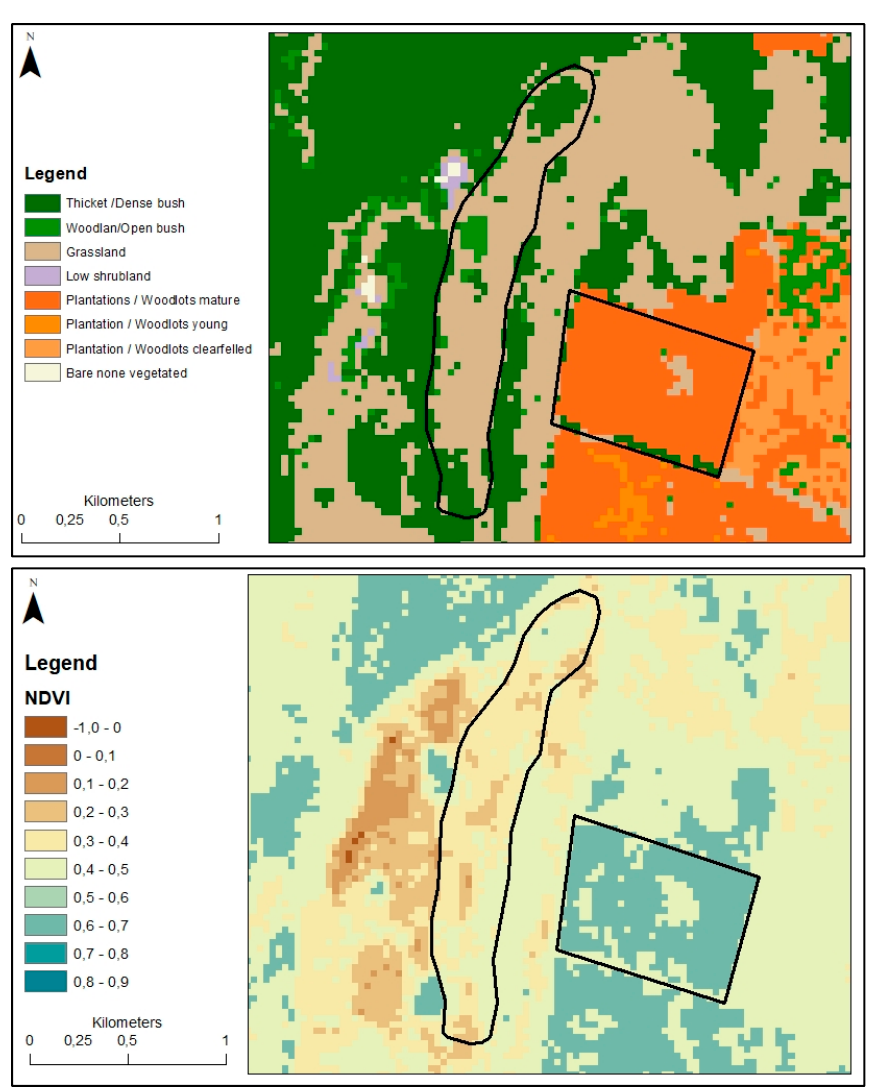
Figure 5. Landcover and Normalized Difference Vegetation Index (NDVI) map of survey sites.